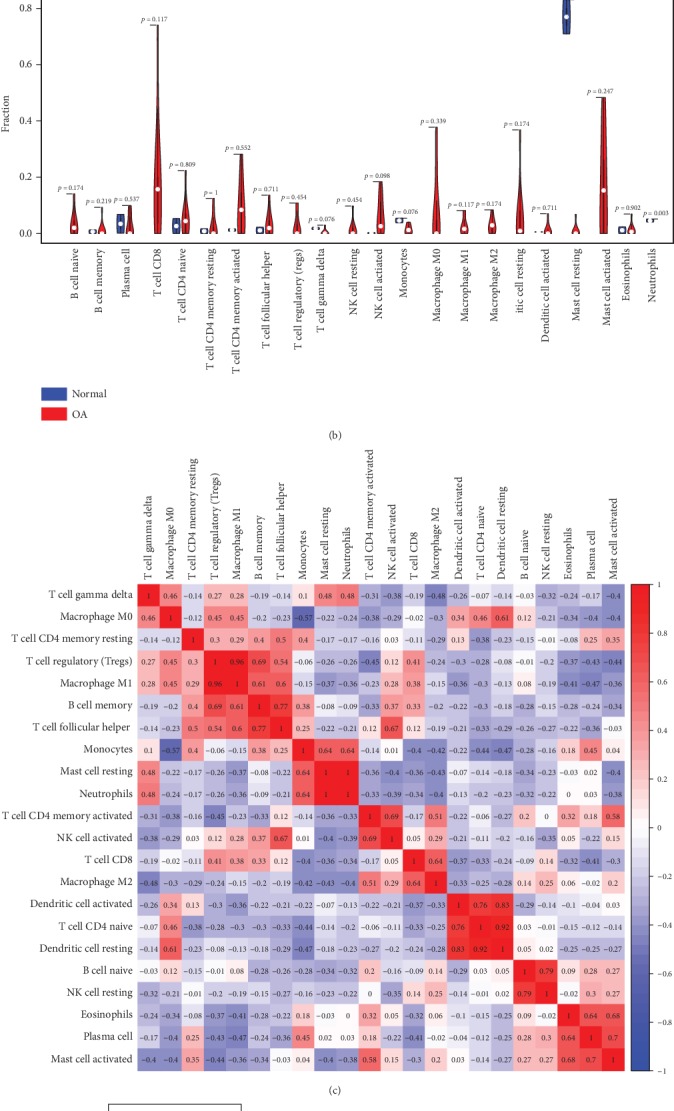
The landscape of immune infiltration in osteoarthritis in subchondral bone. (a) The composition of immune cells for each sample. Normal total: the average composition of immune cells in normal tissue; OA total: the average composition of immune cells in osteoarthritic tissue. (b) The difference of immune infiltration between osteoarthritic tissue and normal tissue. (c) Correlation matrix of all 22 immune cell proportions. (d) Heat map of the 22 immune cell proportions. OA: osteoarthritis.